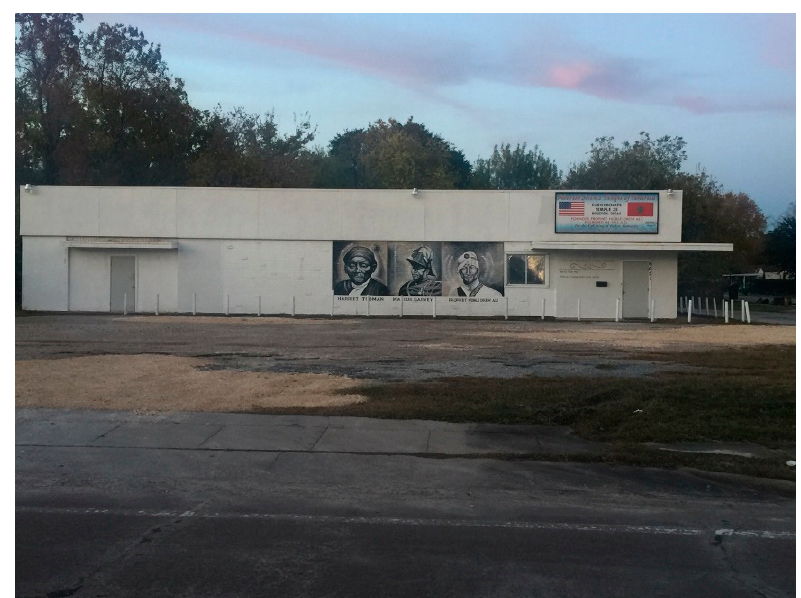
Figure 2. African American history on the side of the Moorish Science Temple of America, across the street from Second Cavalcade Missionary Baptist Church in Fifth Ward, Houston. The portraits, from left to right, include underground railroad conductor Harriet Tubman, Pan-Africanist Marcus Garvey, and founder of the Moorish Science Temple of America, Prophet Noble Drew Ali. Photograph by Denise Frazier.